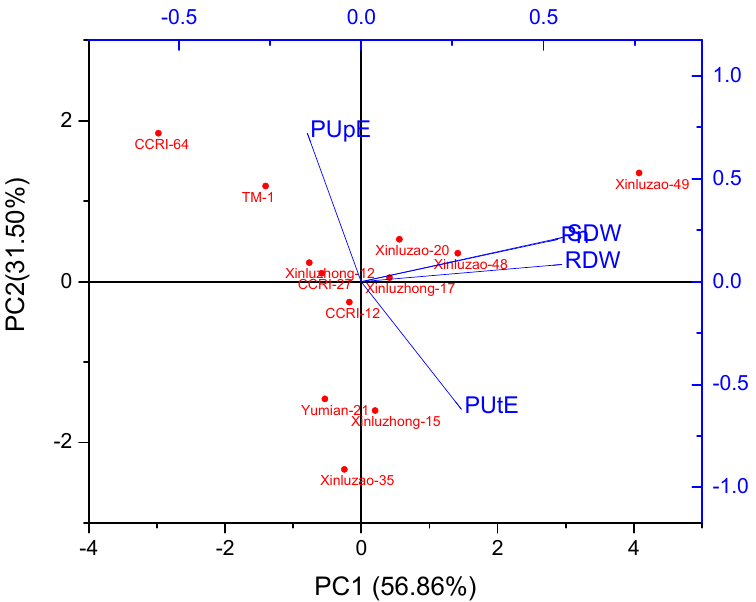
Figure 2. Principal component analysis (PCA) biplot of morphophysiological traits of 12 cotton genotypes grown under various P concentrations. SDW; shoot dry weight, RDW; root dry weight, Pn: net photosynthesis, PUpE; P uptake efficiency and PUtE; P utilization efficiency. Table 12. Principal component analysis of morphophysiological traits under high and low nitrogen either from ammonium nitrate or nitrate.